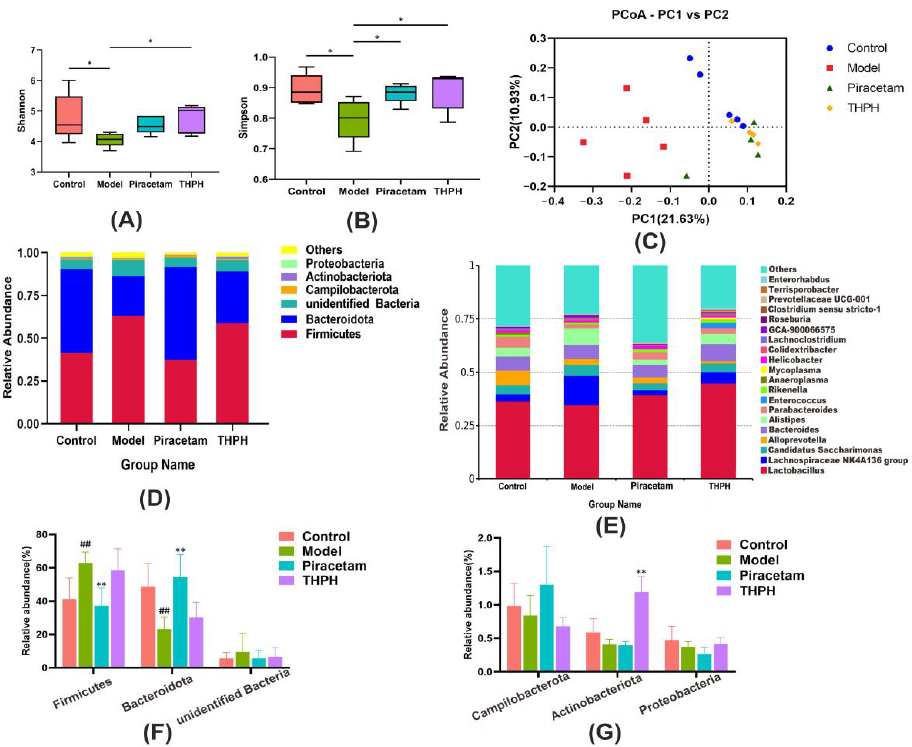
Figure 6. Effect of THPH supplementation on gut microbiota structure in scopolamine-induced am- nesia mice. Feces microbiota composition was analyzed by 16S rRNA gene sequencing. ( A ) Shannon